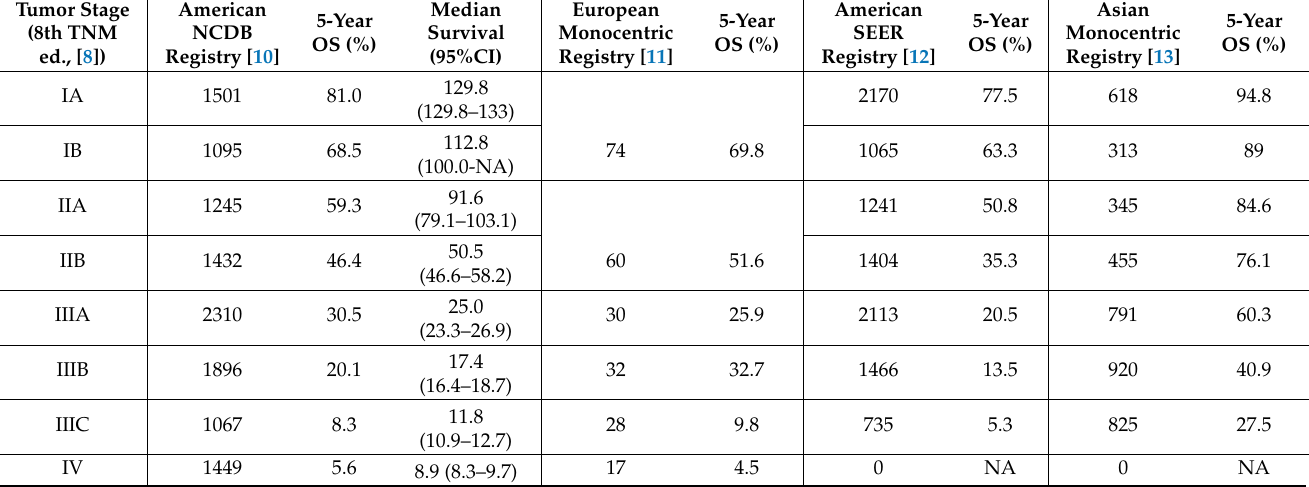
Table 1. Reported prognosis of 5-year overall survival by stage, for patients with gastric adenocarci-